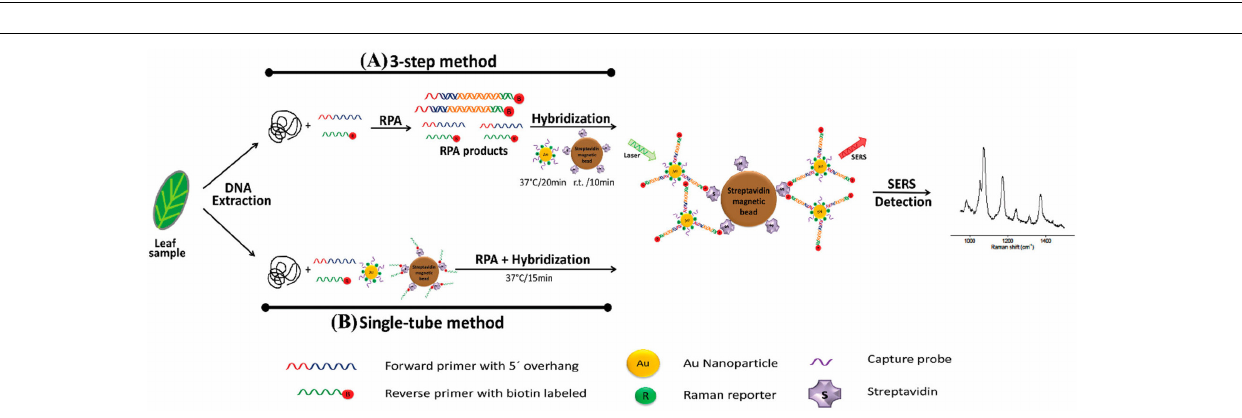
FIGURE 2 | Schematic representation of the DNA-based bridging flocculation assay (reproduced with permission from Wee et al., 2015).